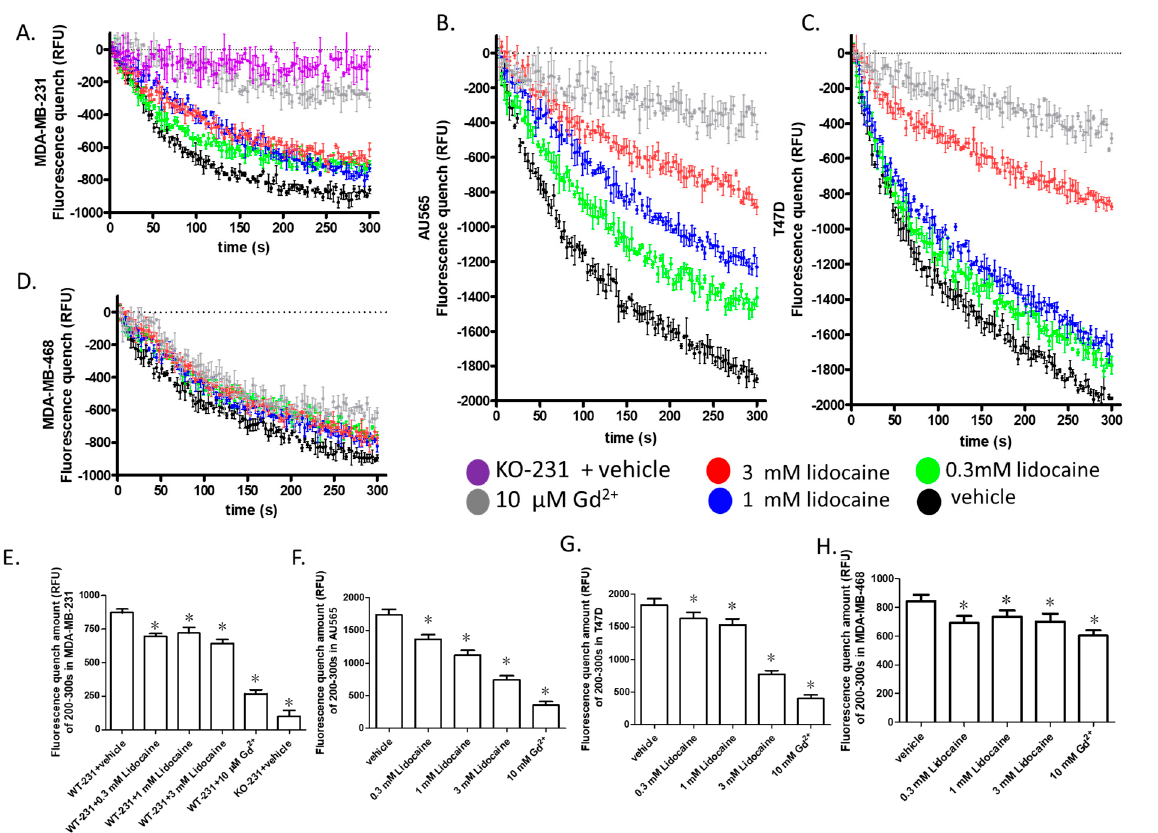
Figure 4. The effect of lidocaine on TRPM7 channels in breast cancer cell lines. ( A – D ). Fluorescence quench assay ( n = 3): The fluorescence quenches followed by the addition of Mn 2+ were plotted on the same scale. 10 µM Gd 2+ was used as the negative control. ( E – H ). The average fluorescence quench amount of 200–300 s in MDA-MB-231, AU565, T47D, and MDA-MB-468. “*” indicates the significant differences ( p < 0.05) compared with the control. The quench data of the vehicle, negative, and 200 µ 2-APB in MDA-MB-231 were published previously [22].